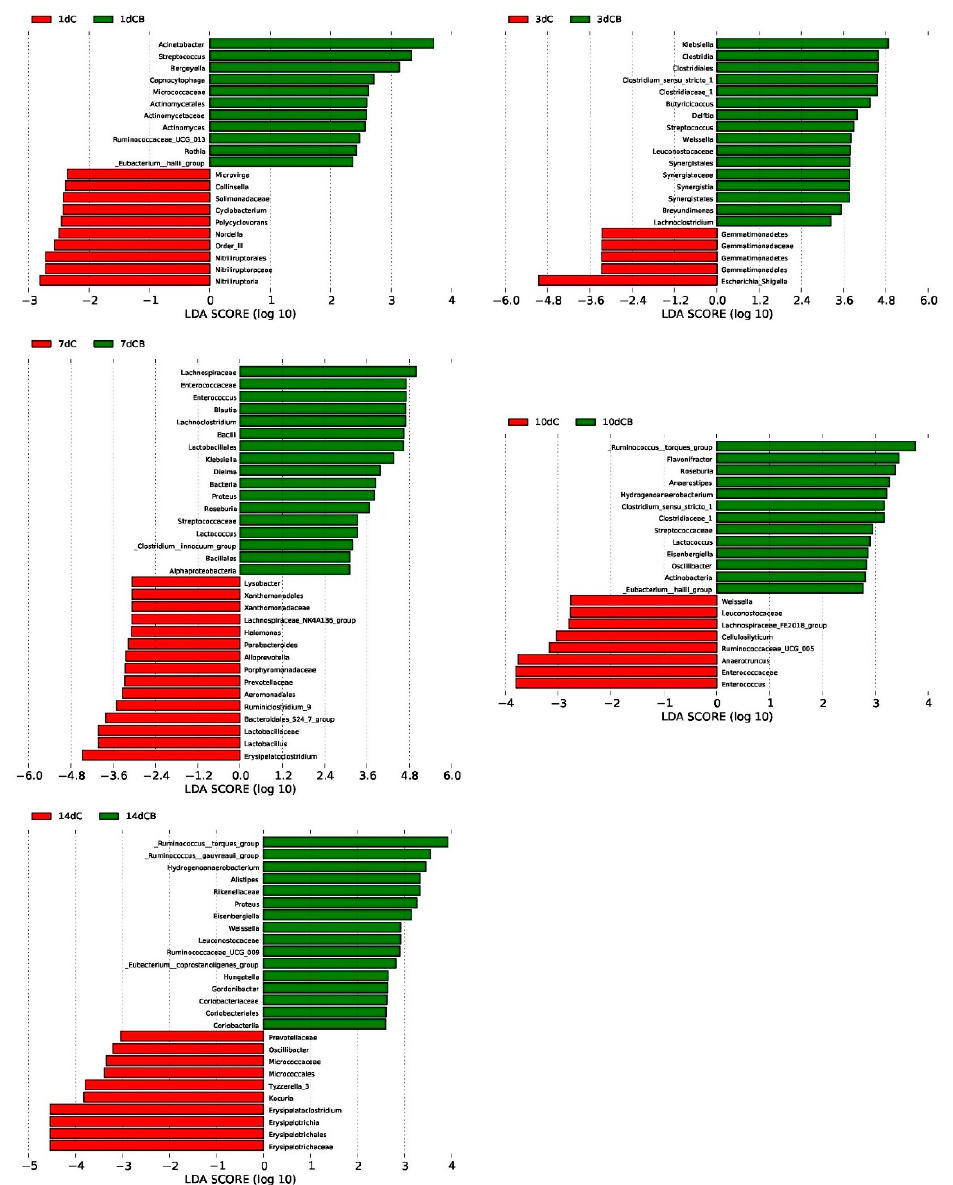
Figure 6. Differentially abundant bacteria between the C group and the CB group at each sampling time point. Histograms of linear discriminant analysis (LDA) scores (threshold = ≥ 2) on Days 1, 3, 7, 10, and 14 (displayed as 1d, 3d, 7d, 10d, and 14d, respectively) are plotted. C, control group; CB, C. butyricum